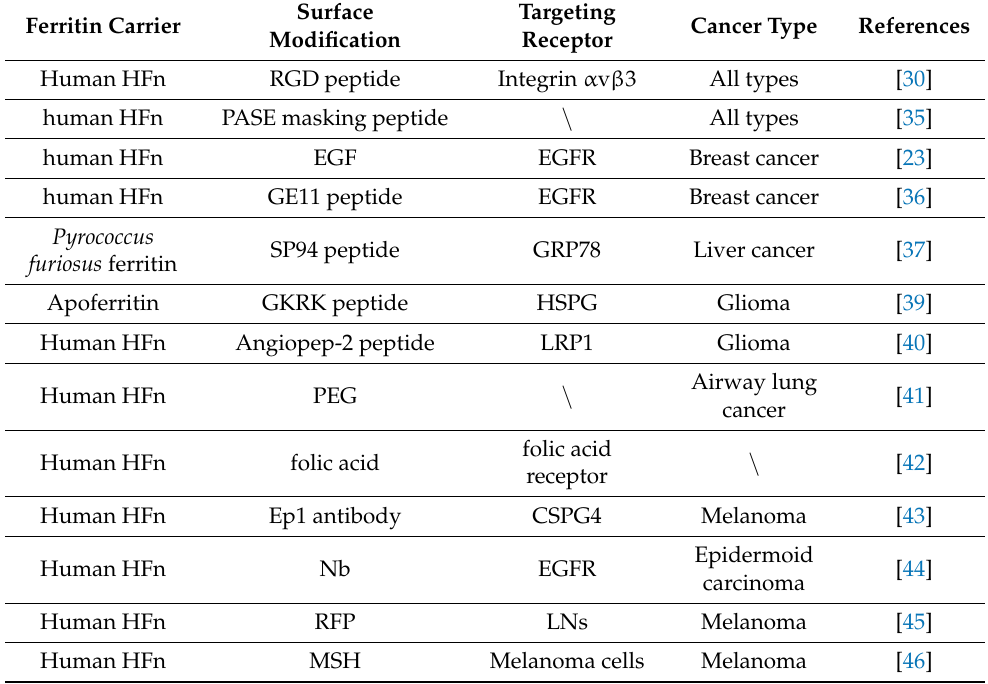
Table 1. Surface modification of ferritin. (Please add this sentence “Table should be cited close to where it is first mentioned. Because of the reference order, please leave the table here.” for comment). Ferritin